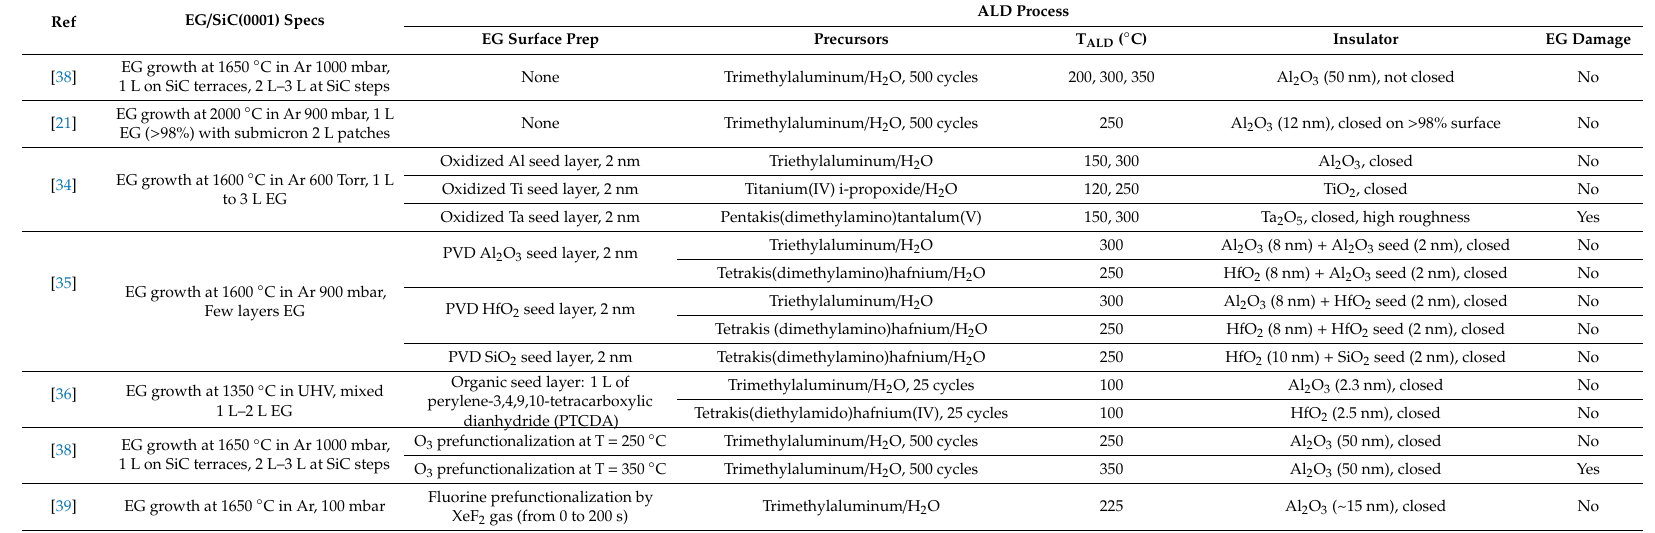
Table 1. Overview of literature reports on atomic layer deposition (ALD) of dielectric materials on EG. Listed are the specs on EG growth process and number of graphene layers, the type of EG surface preparation used to achieve uniform ALD, the used ALD precursors and deposition temperatures, the thickness and uniformity of the deposited dielectric material, and whether EG was damaged by the surface preparation and / or the ALD